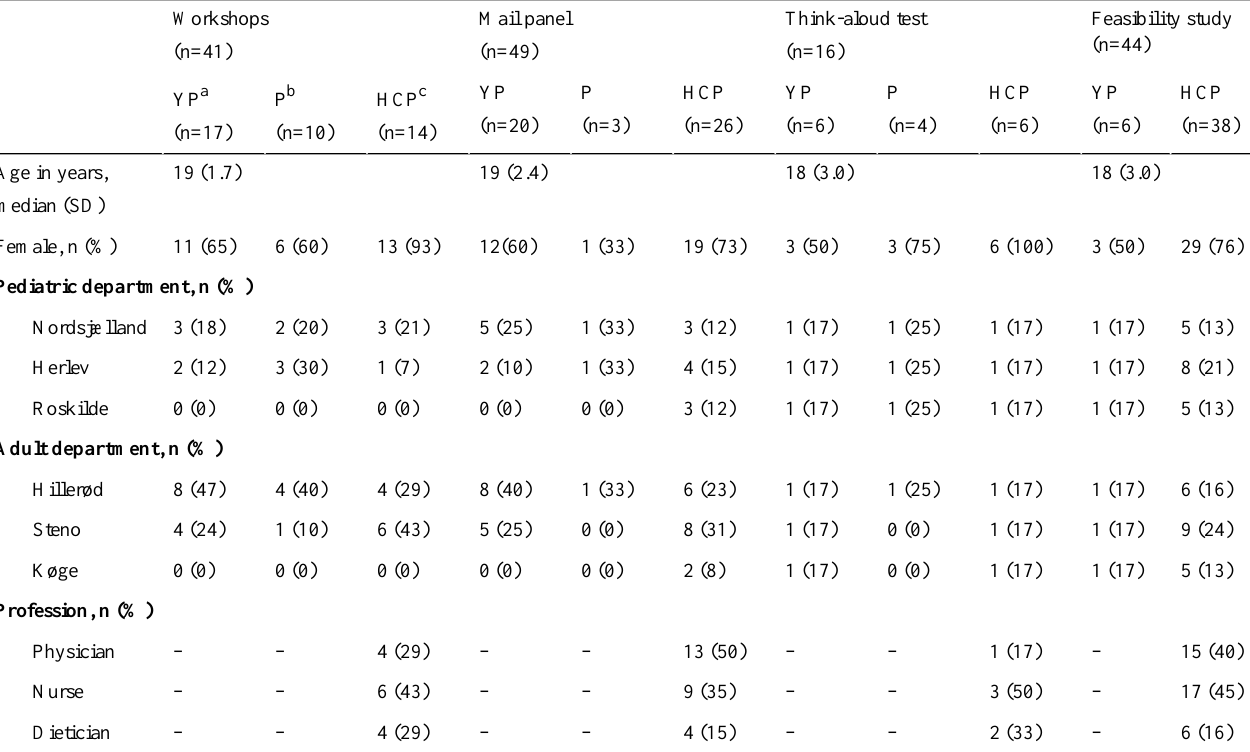
Table 2. Participant